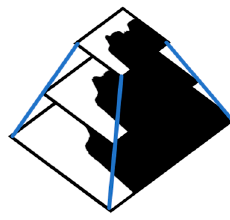
Figure 9. Three layers of image pyramid.